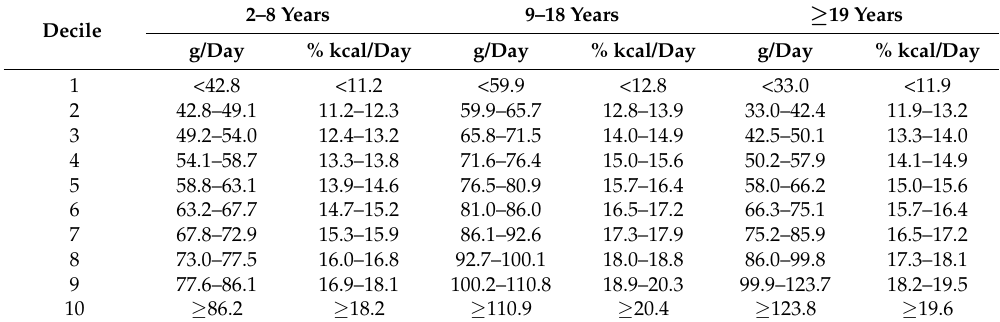
Table 2. Usual added sugars intake by decile of intake by age groups, data from the National Health and Nutrition Survey, 2009–2012 1 .